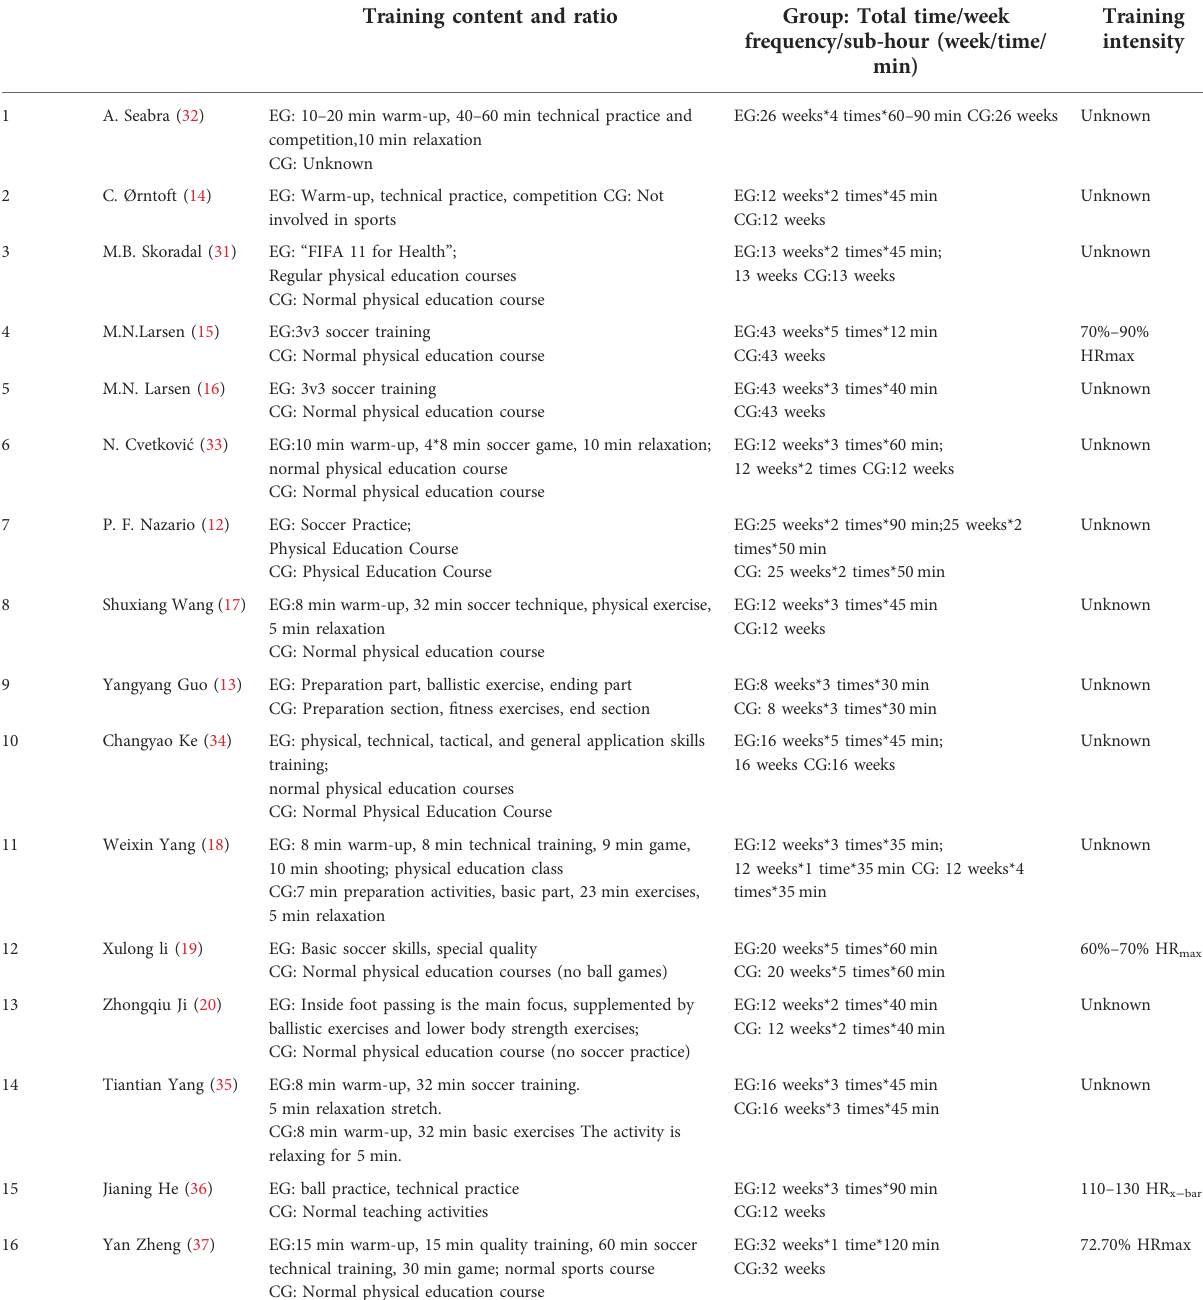
TABLE 2 Status of interventions included in the